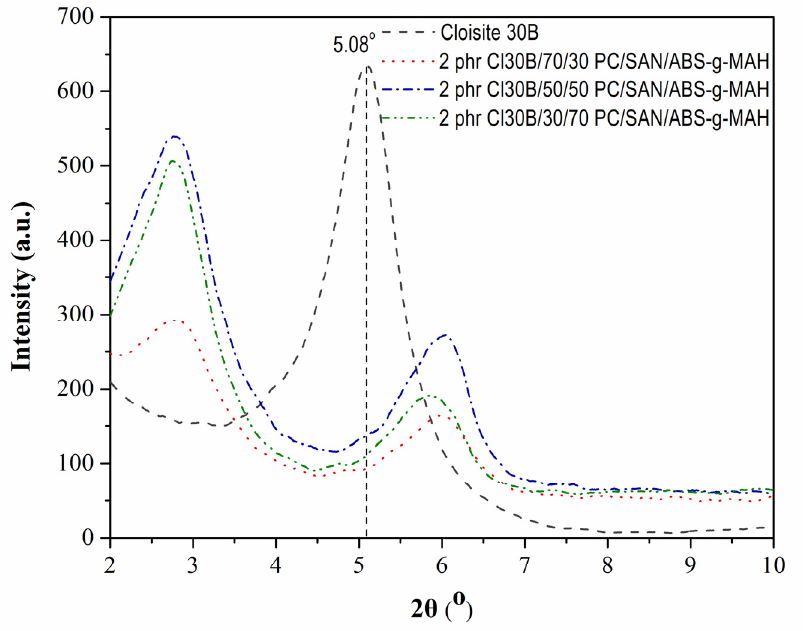
Figure 3. XRD patterns of Cloisite 30B and 2 phr Cloisite 30B/PC/SAN blend nanocomposites, compatibilized with 10% ABS- g -MAH.